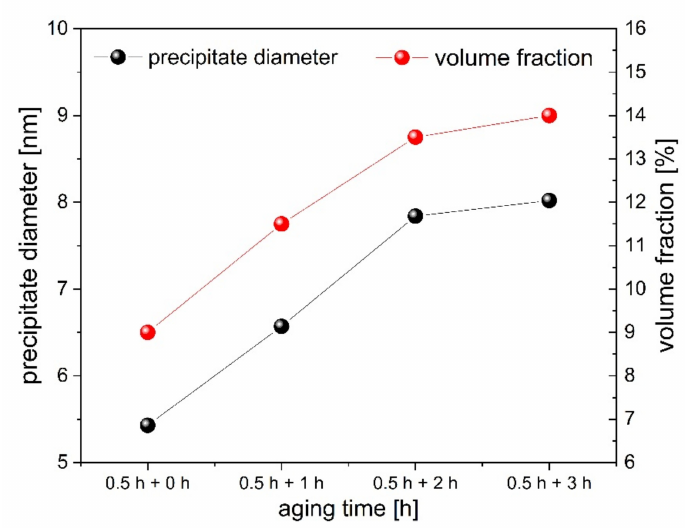
Figure 2. Precipitate diameter and volume fraction of γ ’ as a function of secondary aging (low temperature). The first time regards aging at 973 K, whereas the second regards aging at 723